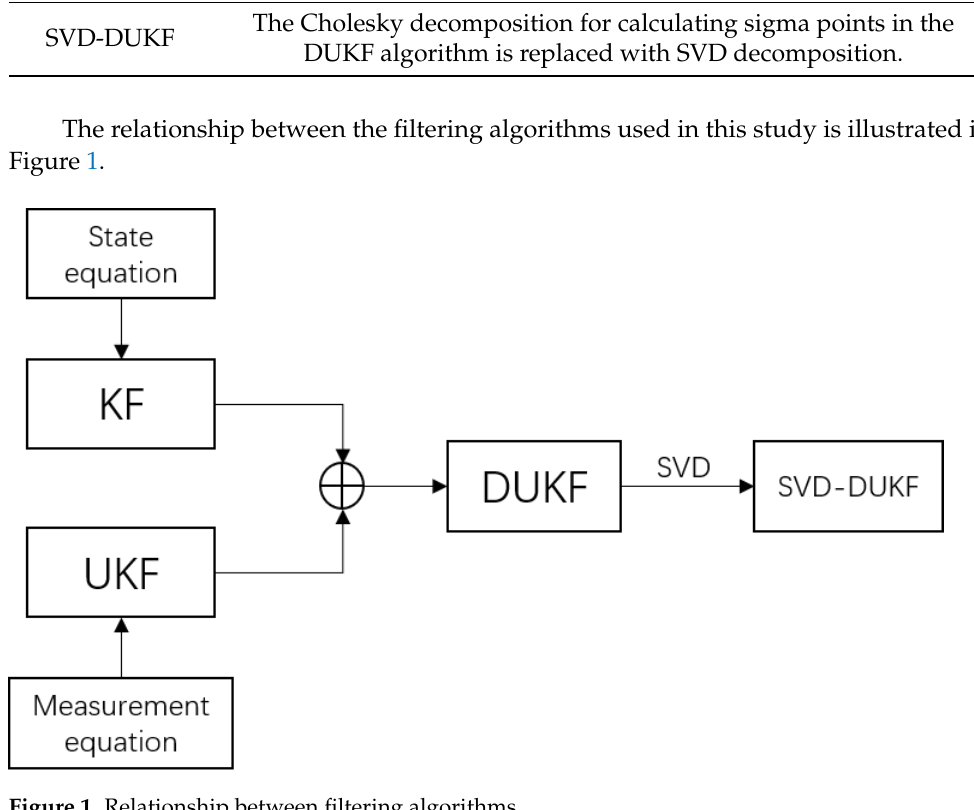
Figure 1. Relationship between filtering